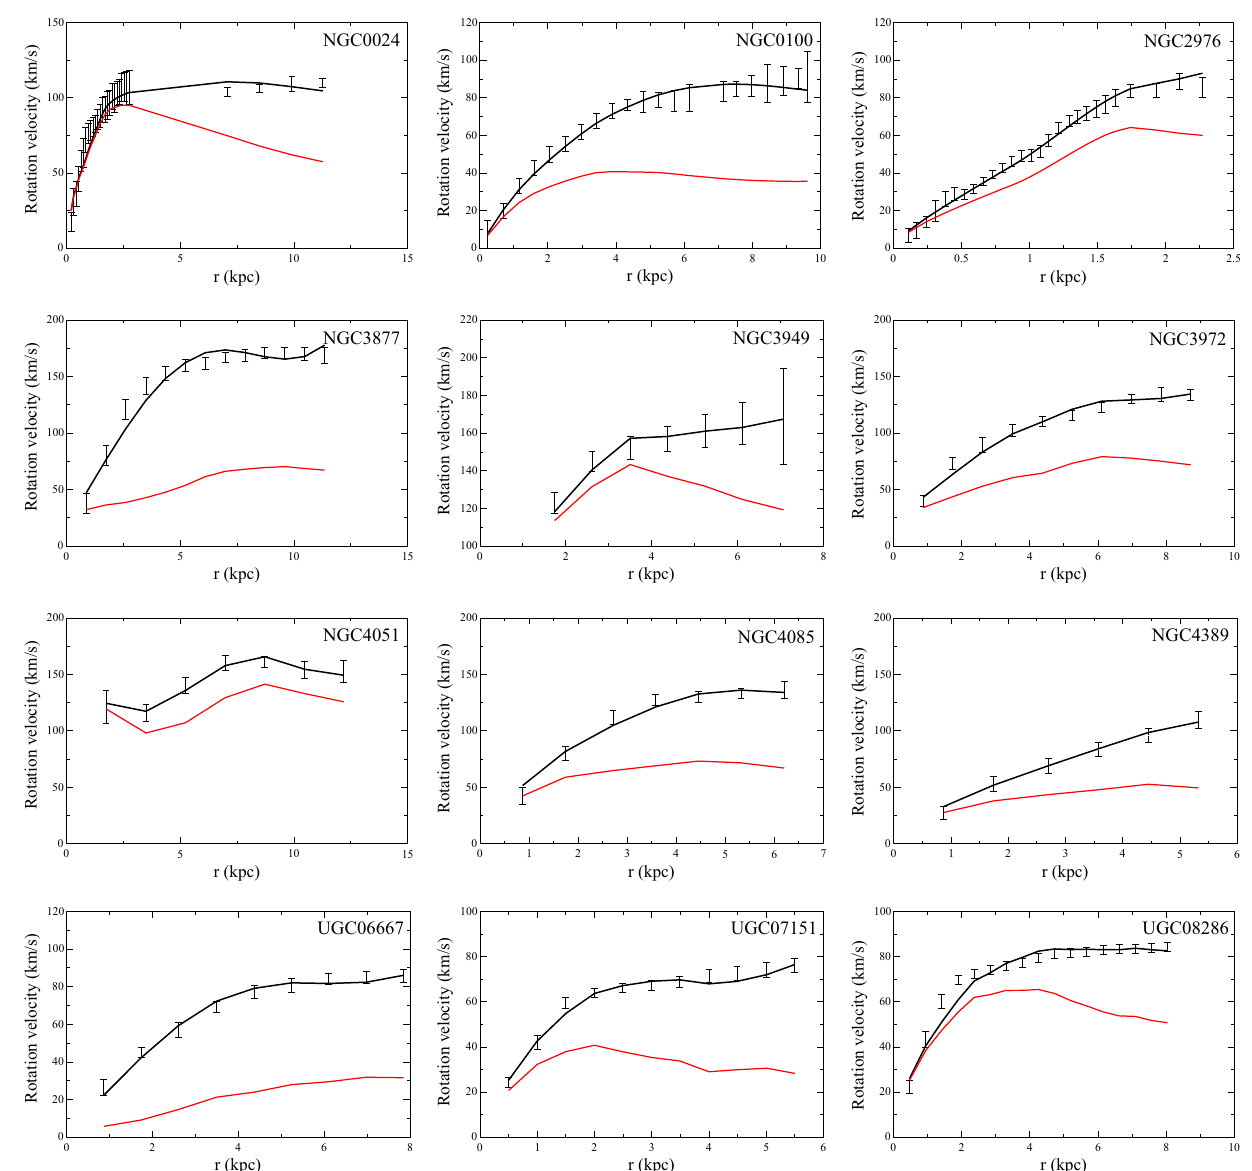
Fig. 6 Best-fit rotational curves of the galaxy sample. The baryonic contributions are represented by the red lines (disk and gas contributions). The black lines represent the best-fit resultant rotation curves. The error bars are the observational data obtained in [138] ρ = 3 . 0 × 10 − 24 g cm − 3 and ω = 2 . 6 × 10 − 16 s − 1 ( χ 2 c 0 . 54). We also show the fit for R = 10 kpc ( χ 2